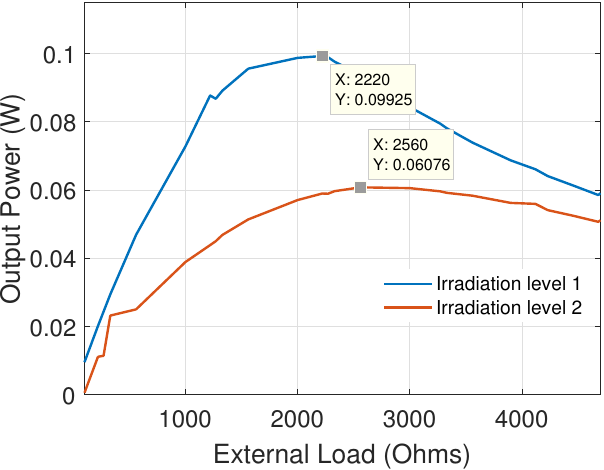
Figure 12. Experimental characteristics of PV output as a function of the external load for two radiation